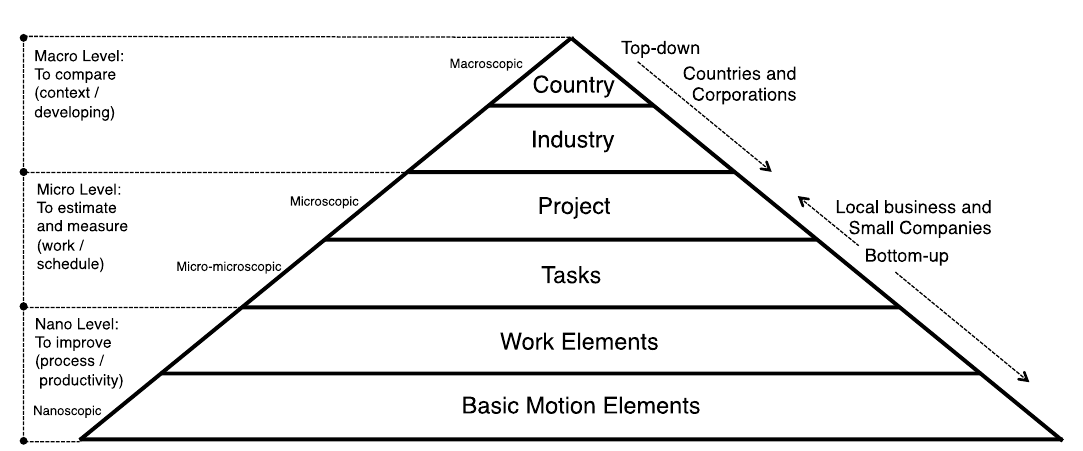
Figure 4. Approach levels to measure performance.